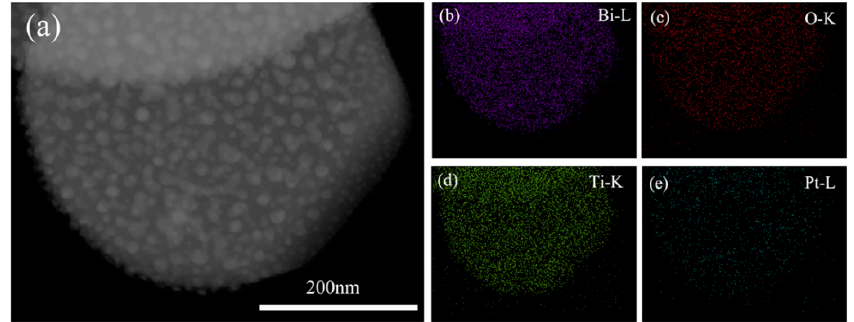
Figure 6. TEM image ( a ) and EDS maps of Bi, O, Ti and Pt ( b – e ) of as-prepared Pt 0.001 / Bi 4 Ti 3 O 12 . ICP-MS results presented in Table 3 revealed that the content of Ag in Ag 0.001 / Bi 4 Ti 3 O 12 and Pt in Pt 0.001 / Bi 4 Ti 3 O 12 photocatalysts was respectively 0.0347 wt% and 0.0782 wt%, while the content of Ag